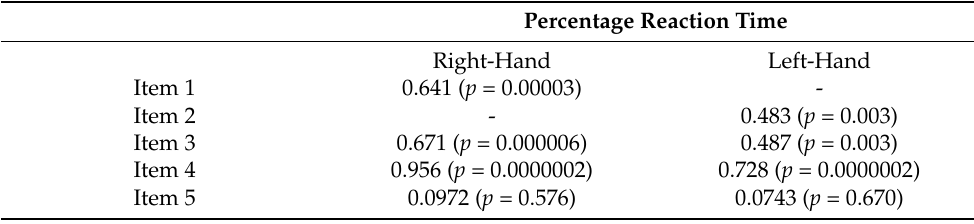
Figure 3. Comparison between ( A ) the mean ± SD reaction time from the experiment group (RT-pre) and the control group (RT-c1) for each hand and ( B ) the mean ± SD reaction time from the experiment group (RT-post) and the control group (RT-c2) for each hand. * Statistical significance with p < 0.05. Table 1. Spearman’s Rho correlation coefficients computed between the items in the VMIQ and the right- and left-hand reaction time percentage